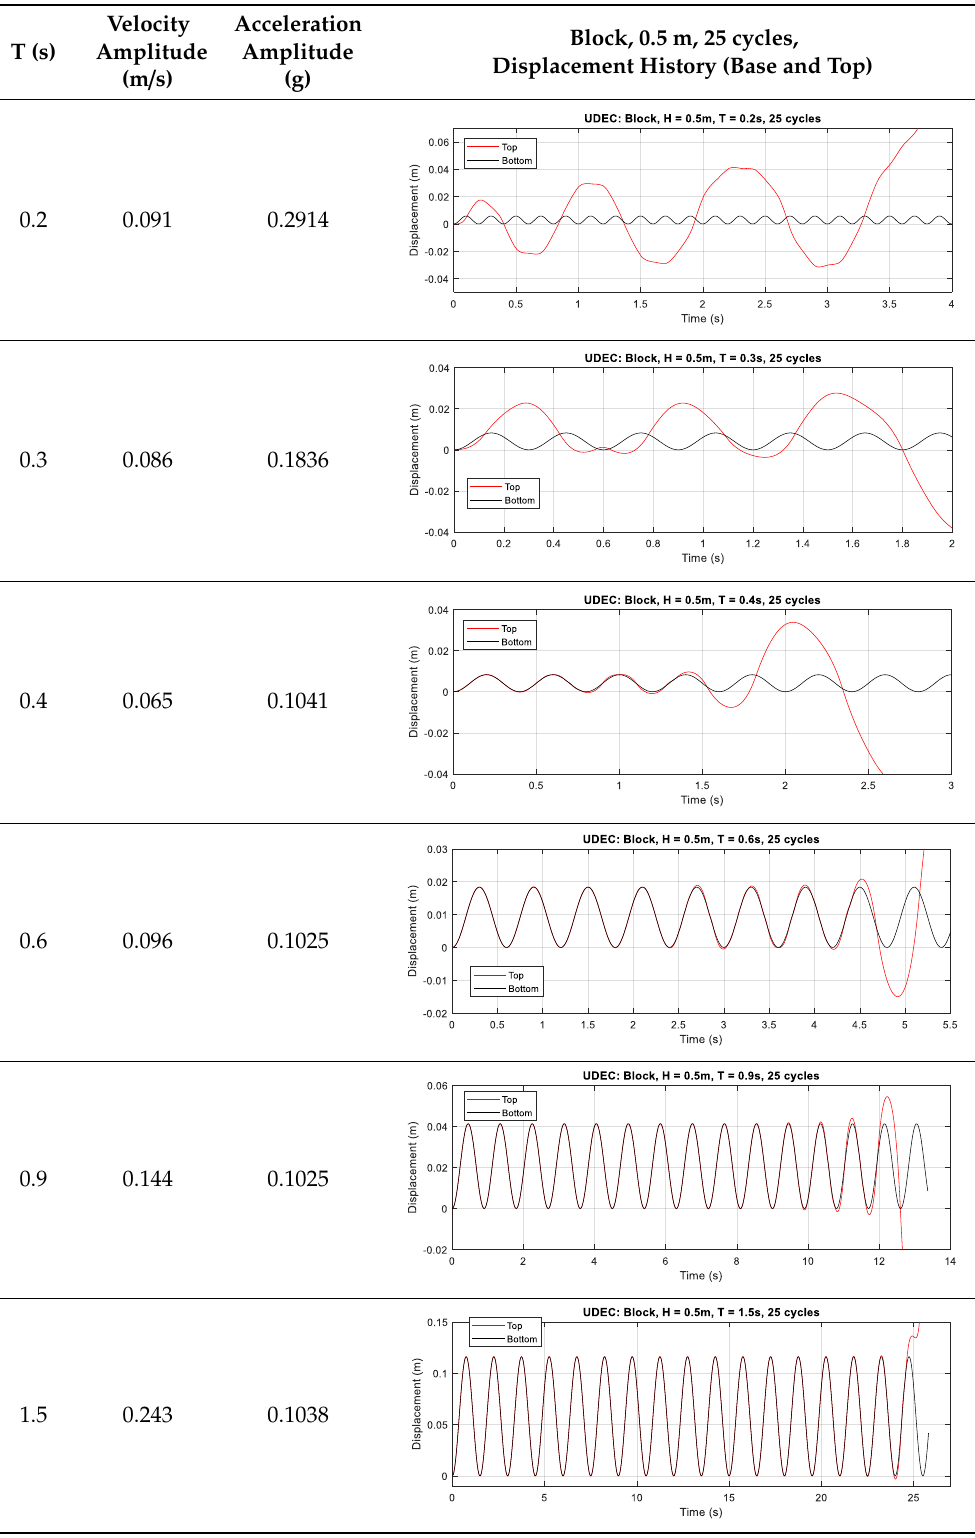
Table 2. Critical combinations for 1 m block UDEC simulation.